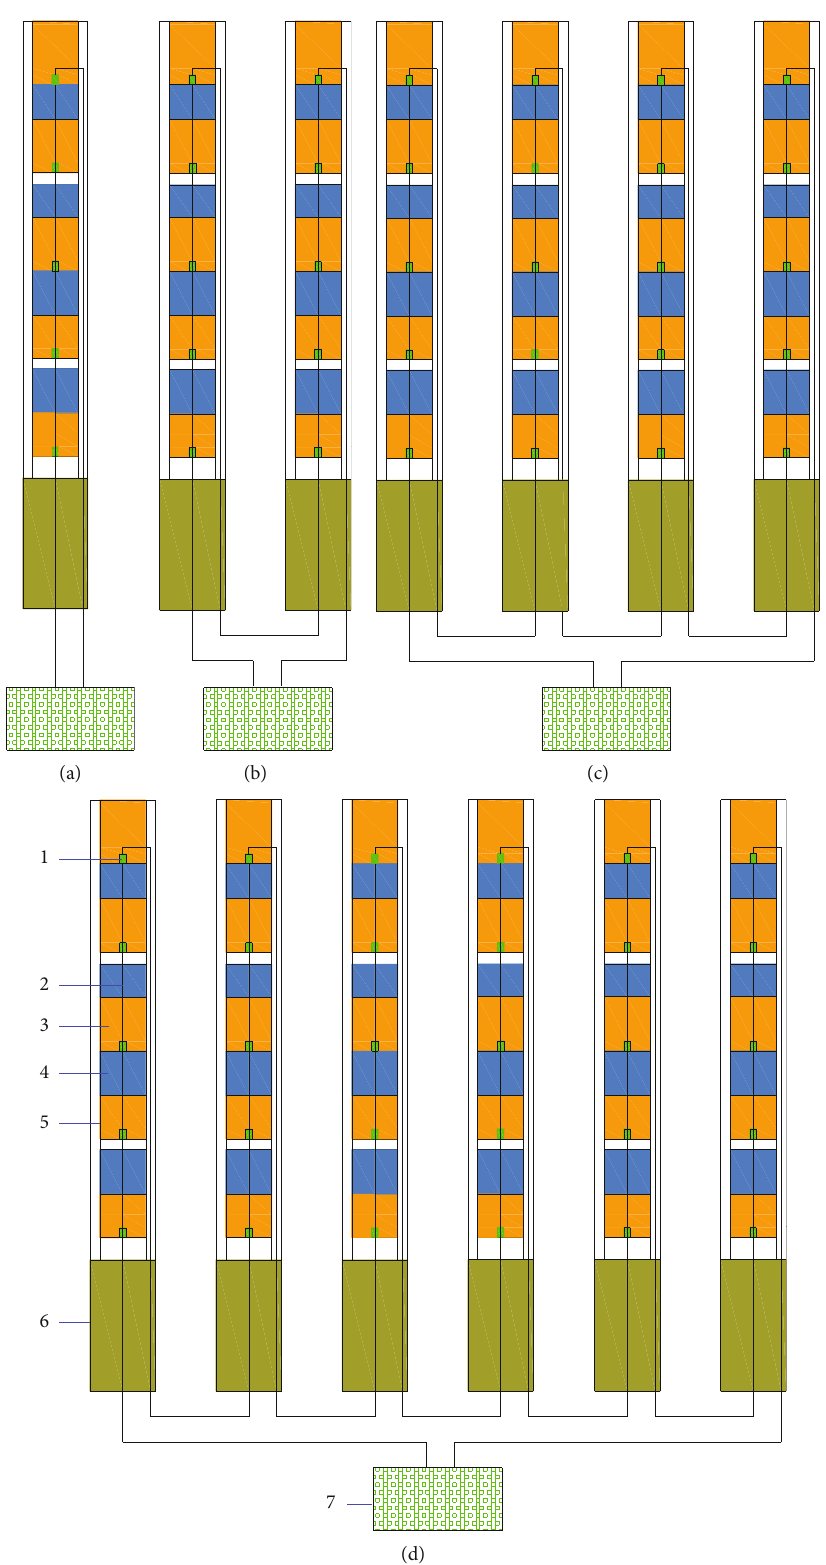
Figure 9: SCHB tests (single-hole charge 4.2kg): (a) single hole, (b) double holes, (c) four holes, and (d) six holes (1: detonator; 2: connecting wire; 3: explosive; 4: water; 5: directional slit tube; 6: sealing mud; 7: detonating